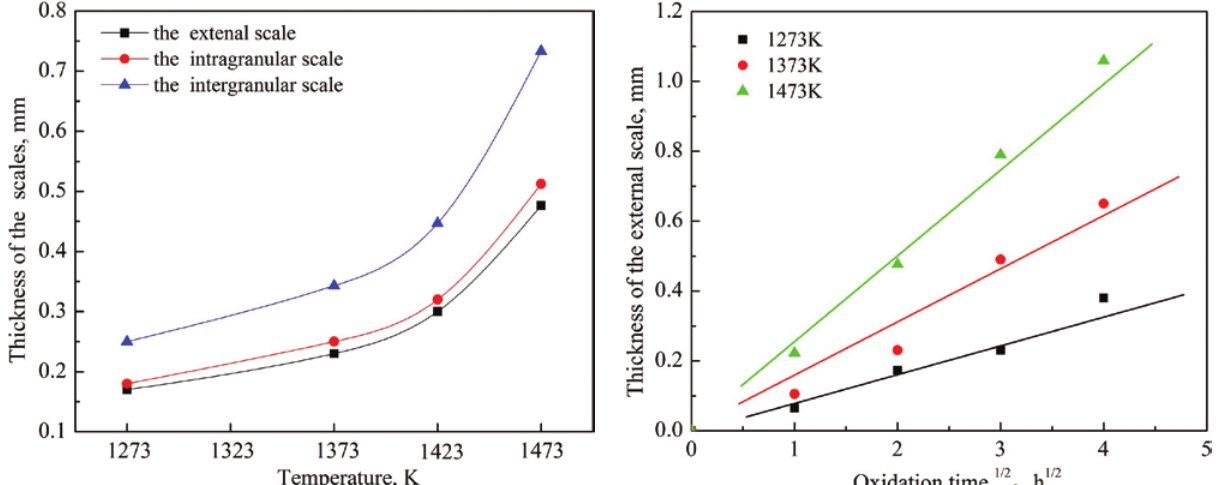
Fig. 8: Relationships between the thickness of external scale and the square root of oxidation time